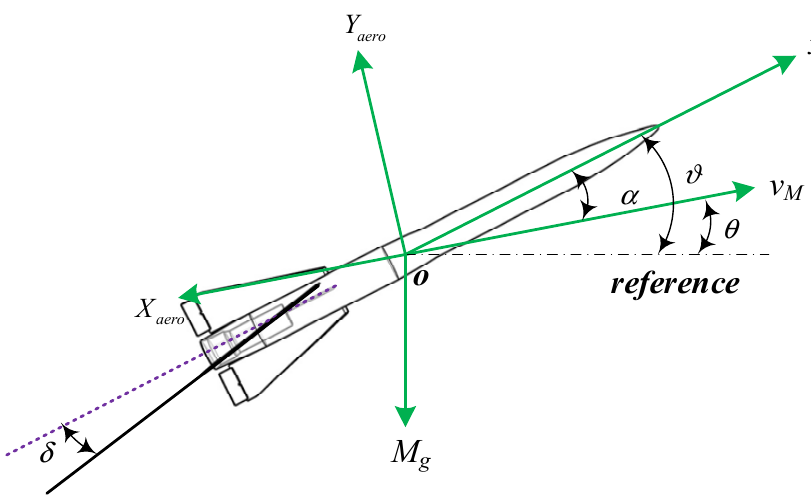
Figure 1. The relative motion of the missile and target.